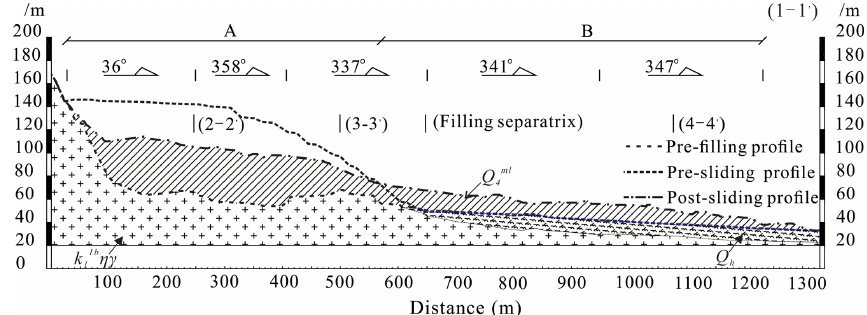
Figure 10. The geological and topographical cross section (profile line 1-1’).